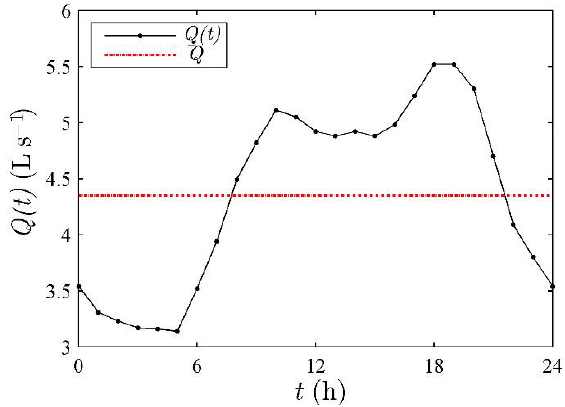
Figure 2. Average hourly values of discharge of the year 2016 referring to the link 8–10.